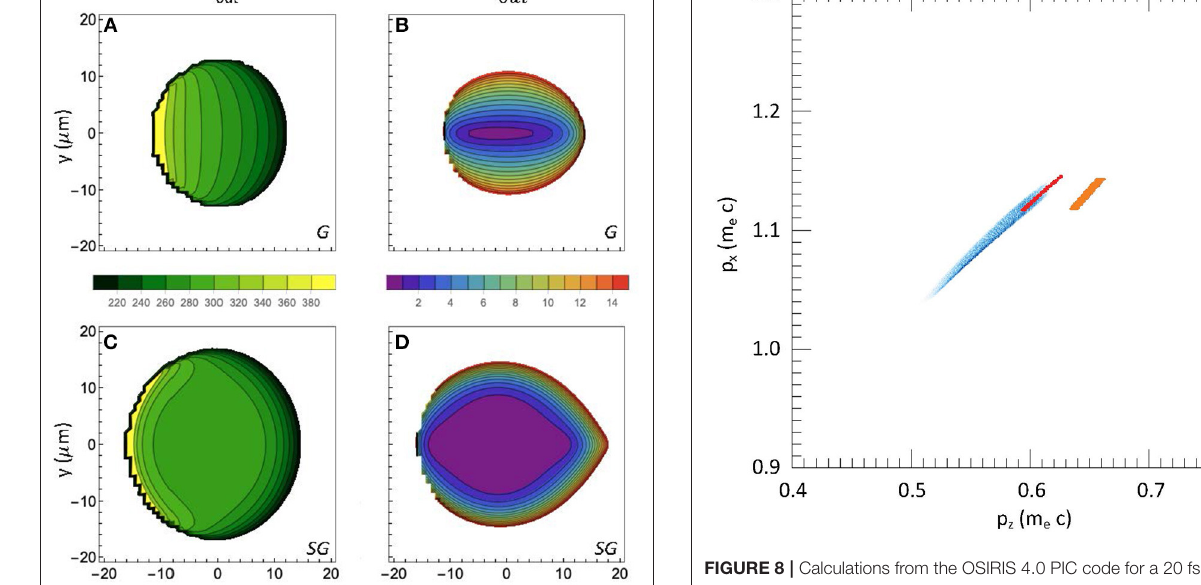
FIGURE 8 | Calculations from the OSIRIS 4.0 PIC code for a 20 fs pulse duration, θ PF = 60 ◦ , and U P 0 = 200 keV , showing the distribution of output electrons (blue) in the p z − p x plane, starting from an electron bunch 2.5 µ m wide in the X and Z directions centered at ( X 0 , Z 0 ) = (0,20 µ m ). The additional dots show the prediction from the single particle model for the same range of transverse initial positions, centered at (0,0) (orange) and 0,20 ( µ m )